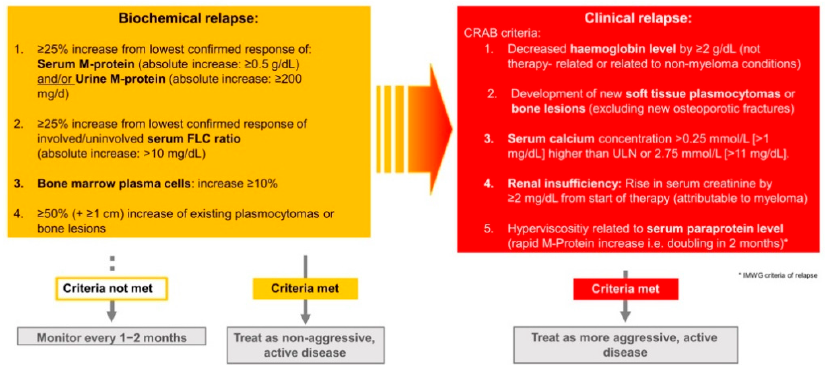
Figure 1. Definition of relapse and indication for treatment. Since MM is an incurable disease, almost all patients experience at least one or more relapses over the course of their disease. It is of great importance to define the right time point to restart or change therapy. The CRAB criteria as well as the IMWG criteria, representing defined biochemical markers of relevance for disease outcome, indicate the need for antimyeloma treatment. If a myeloma patient does not present with typical symptoms or if an increase in biochemical markers is not significant enough, therapy is not imminent; instead, close monitoring of the patient and the decisive diagnostics every 1–2 months should follow. Abbreviations: CRAB criteria = hypercalcemia, renal failure, anemia, bone lesions, FLC = free light chain (monoclonal immunoglobulin light chain), IMWG = international myeloma working group, M-protein = abnormal antibody/monoclonal proliferation of plasma cells, ULN = upper limit of normal.